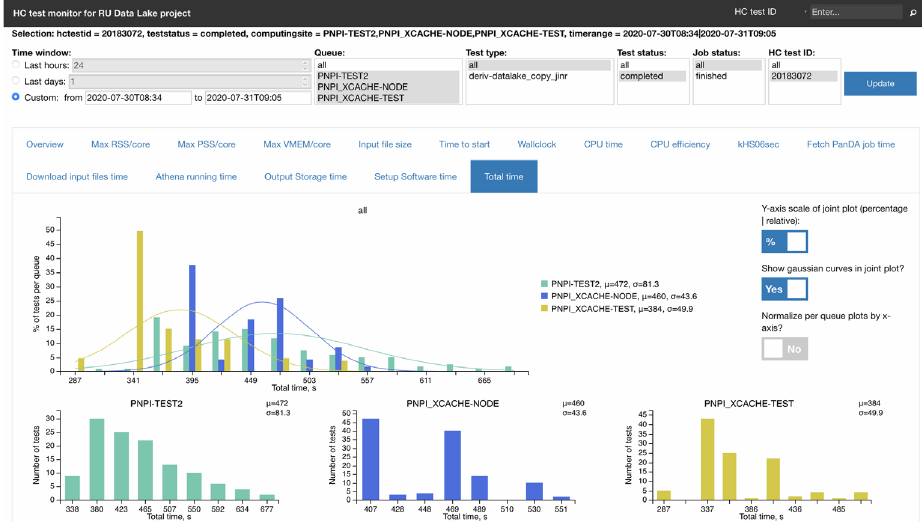
Figure 4. The monitoring web application